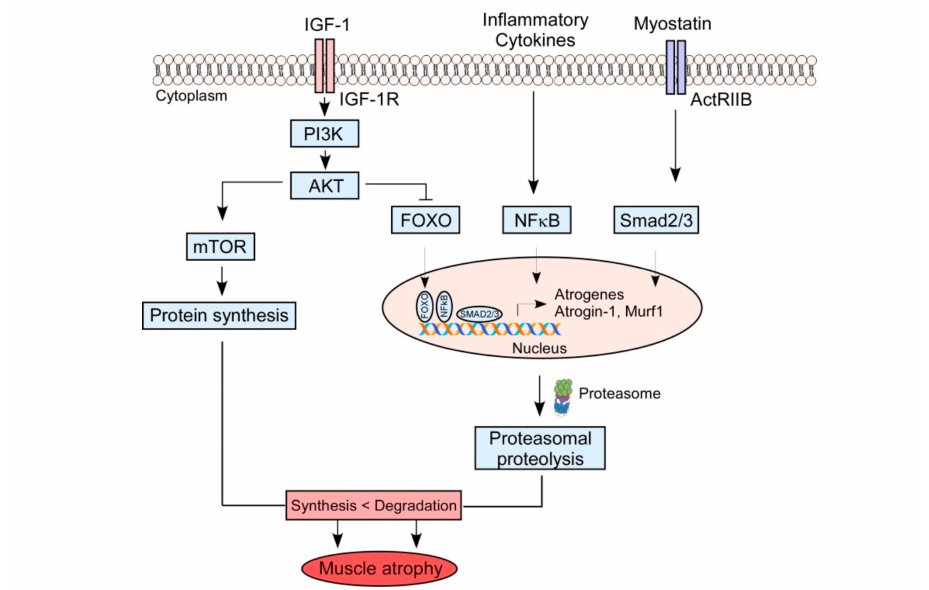
Figure 1. Putative molecular mechanisms involved in the development of sarcopenia during aging. Skeletal muscle protein homeostasis is regulated by balancing protein synthesis and degradation. Insulin-like growth factor I (IGF1)-Akt pathway controls muscle growth via activating the kinase mammalian target of rapamycin (mTOR) and inhibiting the members of the class O of forkhead